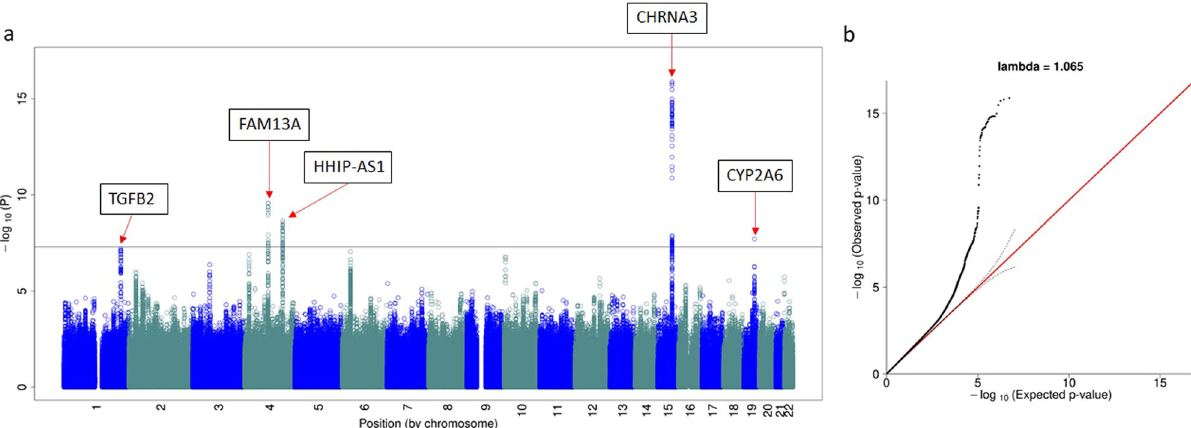
Fig. 4 Meta-analysis results for replication of GWAS hits for COPD. The Manhattan plot ( a ) shows the replicated signals, while the QQ-plot ( b ) shows in fl ation due to the true signal.